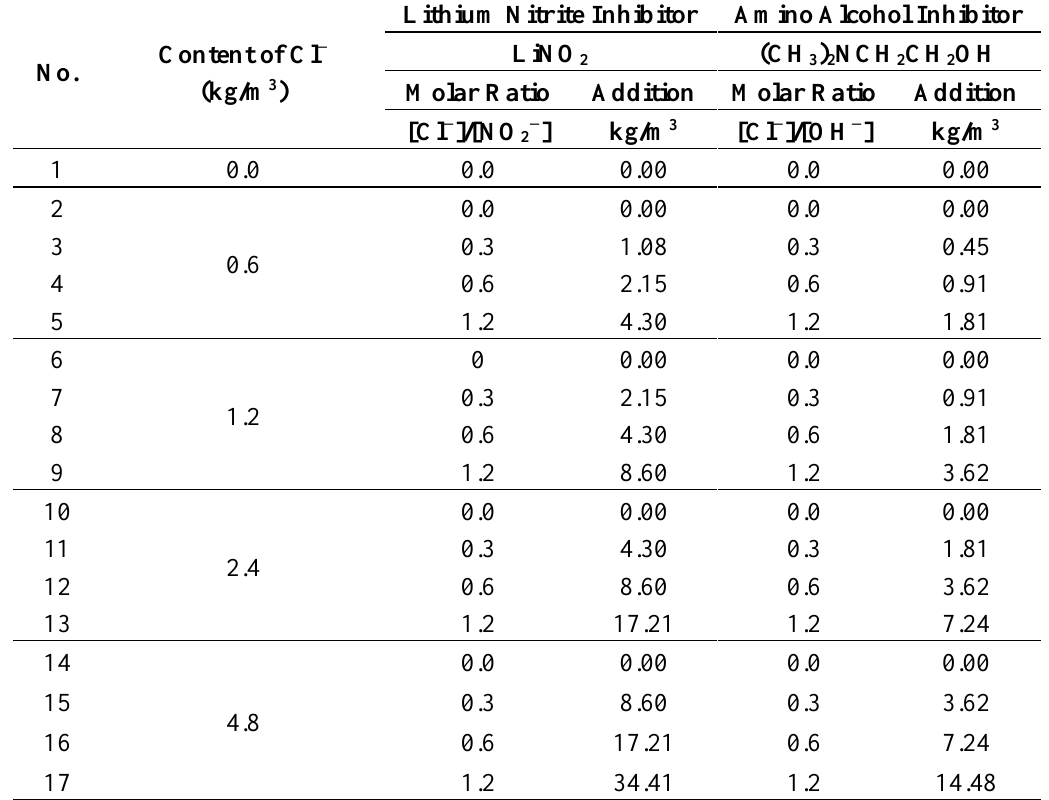
Table 3. Experimental testing parameters